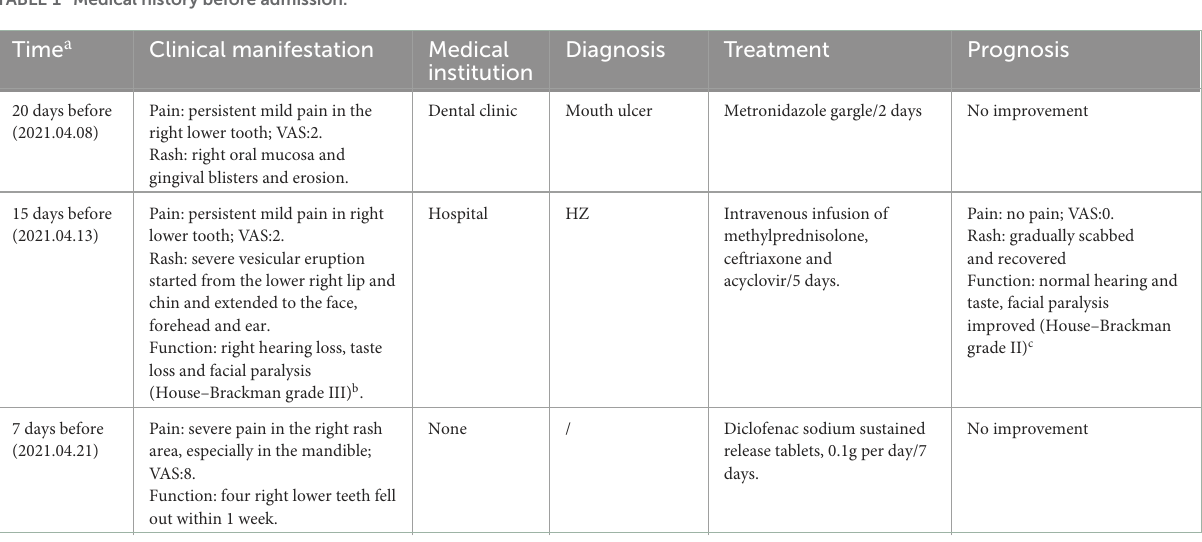
TABLE 1 Medical history before